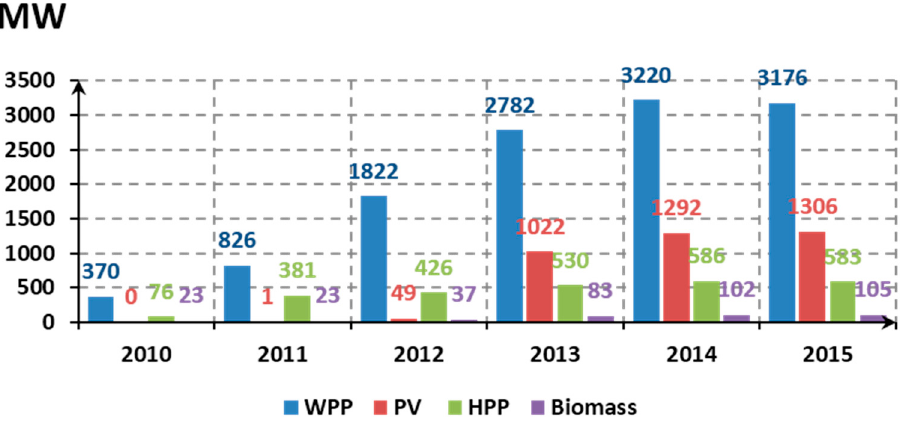
Figure 1. The evolution of renewable energy sources (RES) in Romania in 2010–2015.